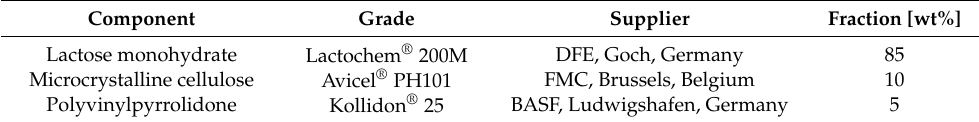
Table 1. Composition of the